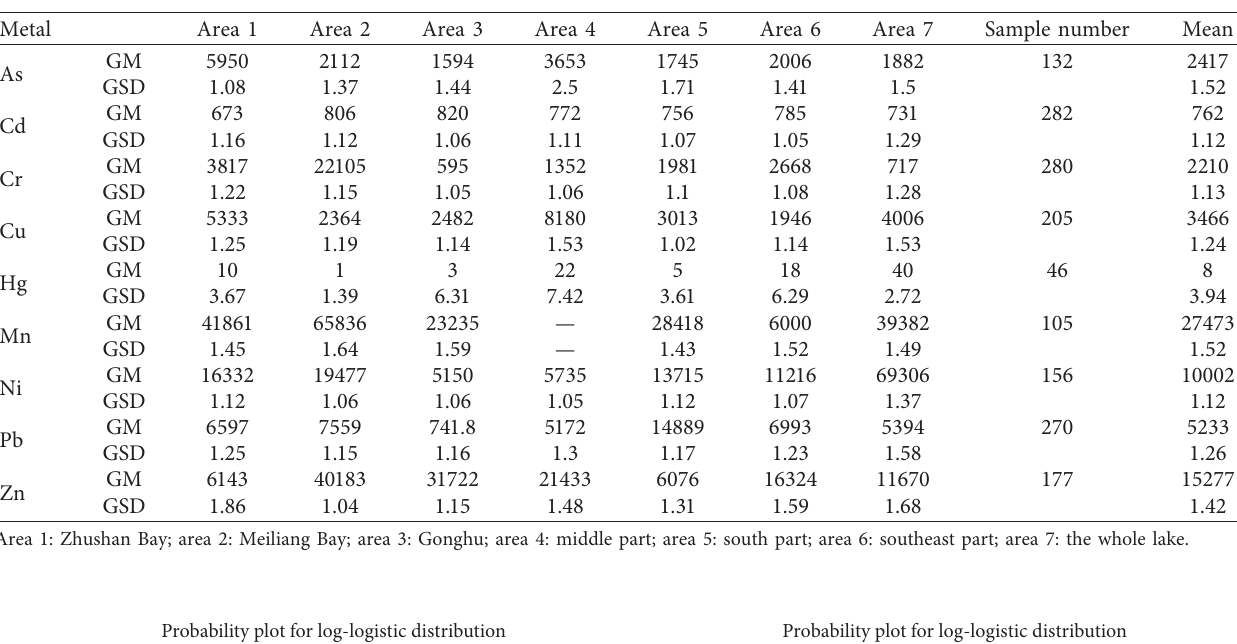
Table 2: Total concentrations (ng/L) of metals in Lake Taihu.